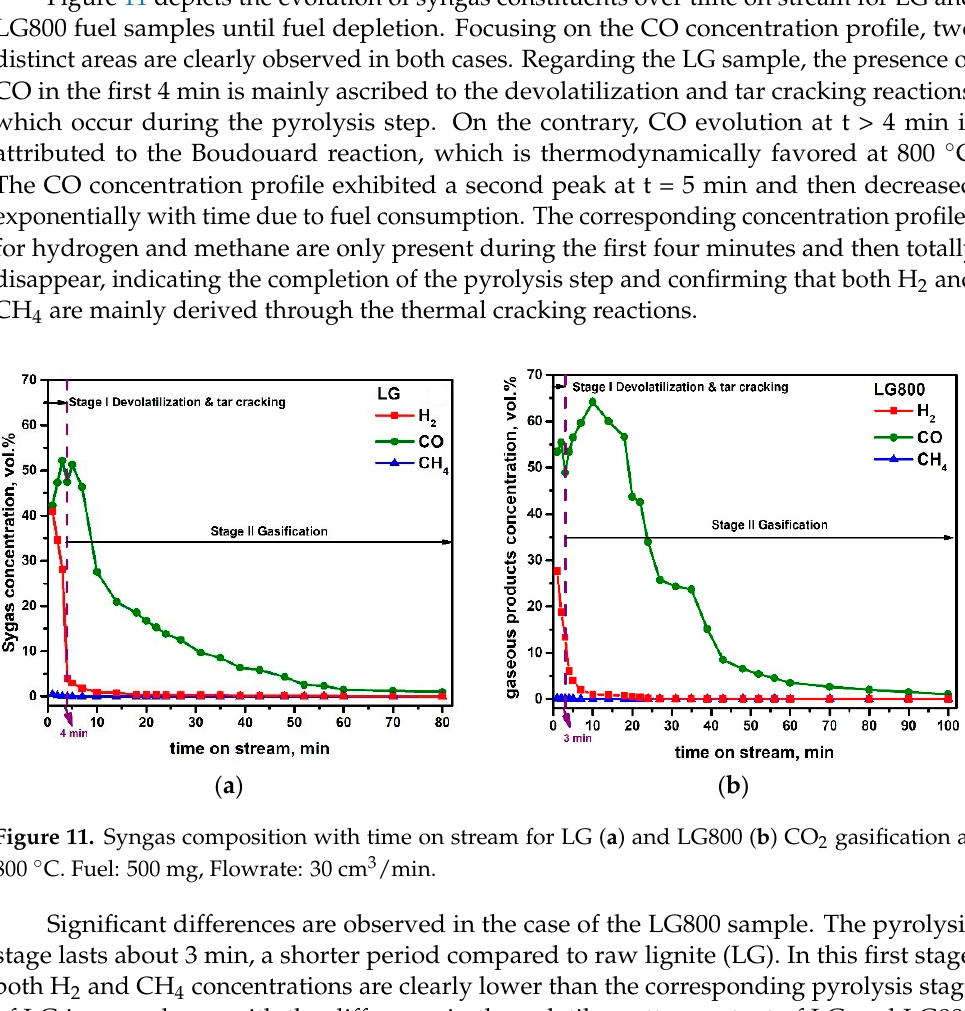
800 ◦ C. Fuel: 500 mg, Flowrate: 30 cm 3